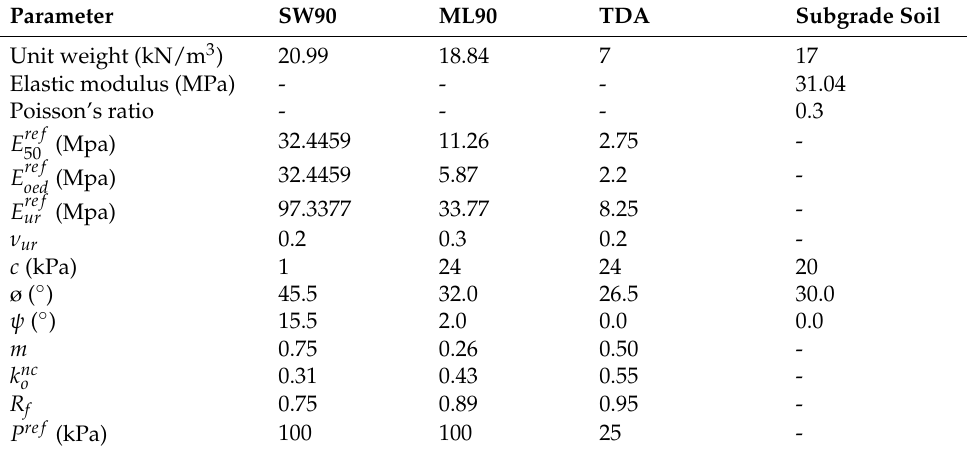
Table 2. The properties of the SW90, ML90, TDA, and subgrade soil used in the research.